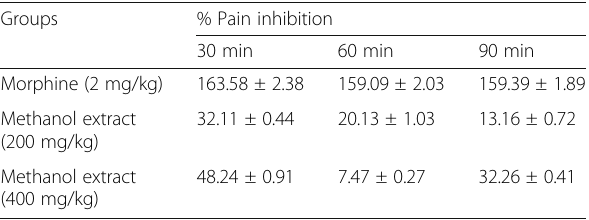
Table 6 Anti-nociceptive activity of methanolic crude extract of L. speciosa flower Groups